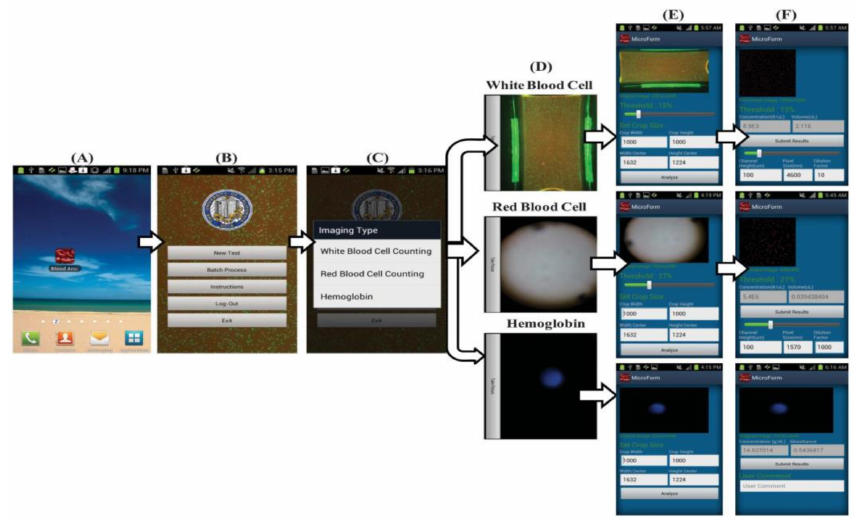
Figure 16. ( A – F ) Steps involved in the Android application to perform blood analysis and display results on a smartphone. Figure adapted with permission from